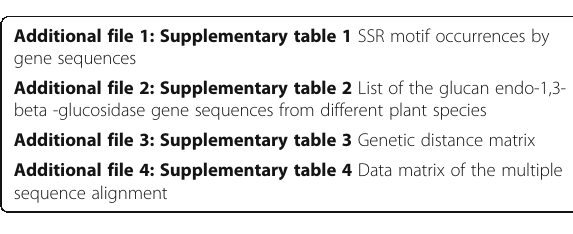
Additional file 3: Supplementary table 3 Genetic distance matrix Additional file 4: Supplementary table 4 Data matrix of the multiple sequence